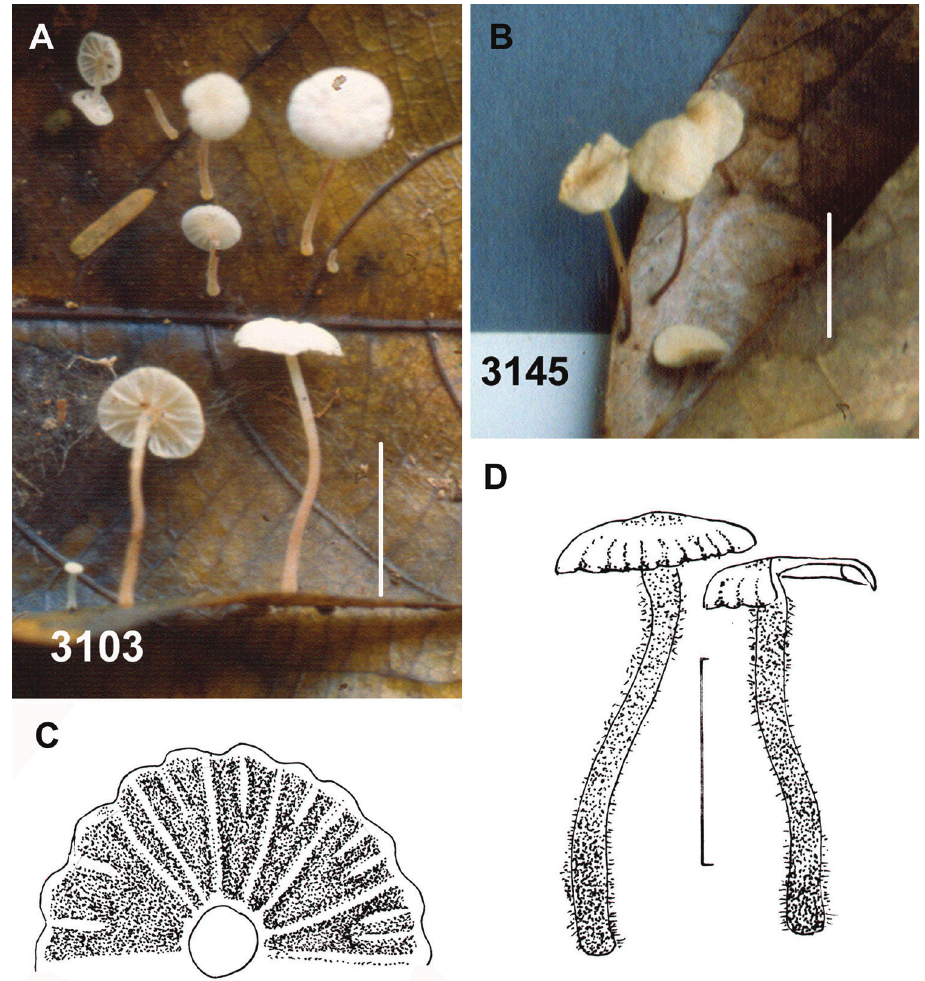
Figure 86. Mycetinis yunnanensis . Basidiomata. A TFB 3103 B TFB 3145 C Arrangement of lamellae and lamellulae D Basidiomata. Standard bars: A, B, D = 10 mm. C = not to